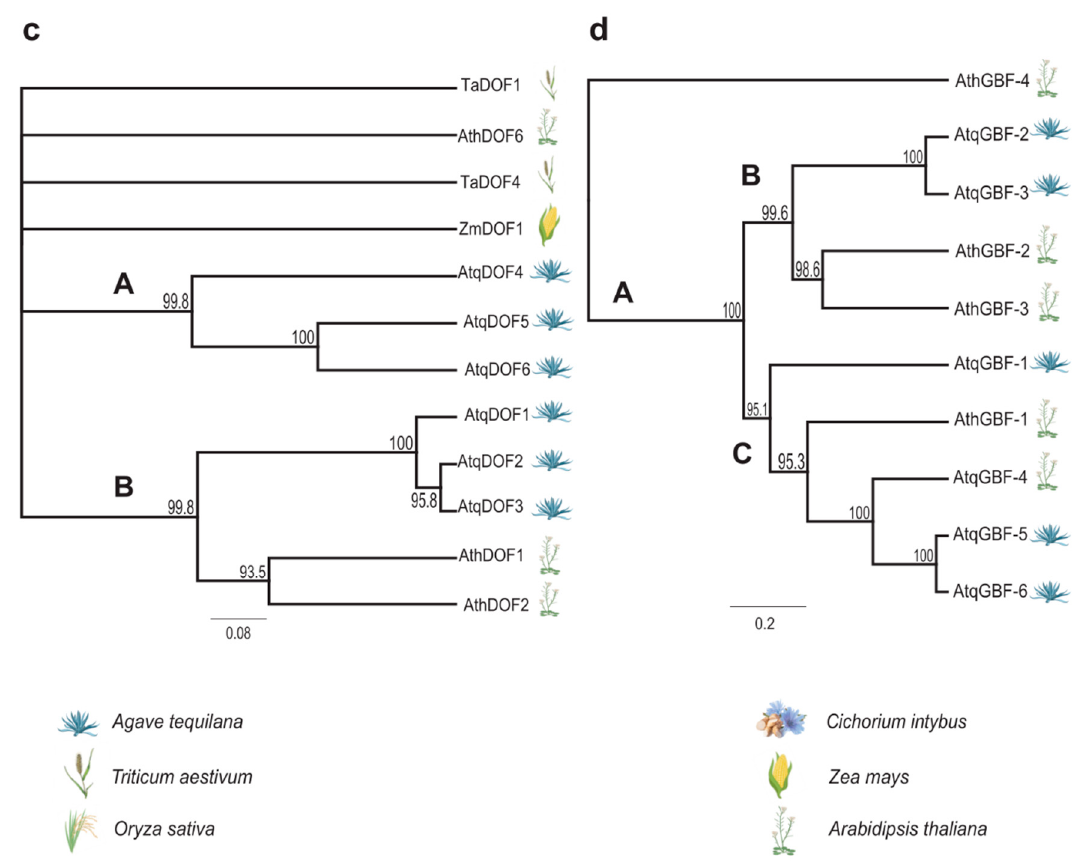
Figure 6. ( a – d ) Relationships between amino acid sequences of the ( a ) MYB, ( b ) GATA, ( c ) DOF and ( d ) GBF transcription factors from A. tequilana and other plant species. Letters indicate different clades and numbers indicate Bootstrap analysis values. Phylogenetic analyses were carried out using complete amino acid sequences and considering all sites including gaps/missing information based on the UPGMA method and the Jukes-Cantor genetic distance model. Symbology represents the species analyzed.